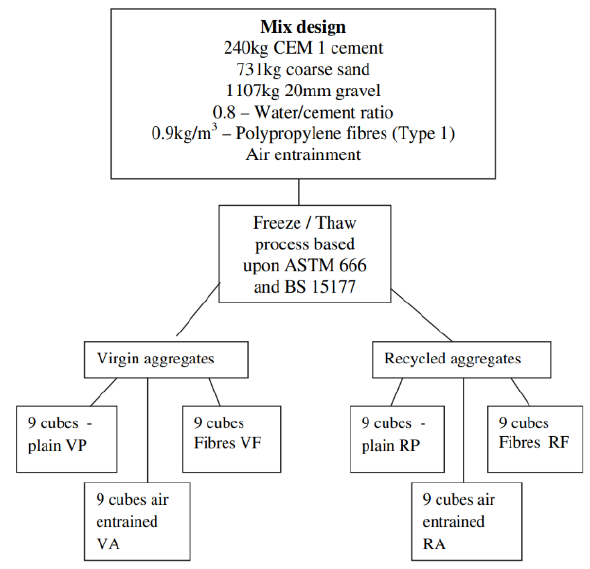
Figure 2. Schematic view of the fabrication process used in the recycled aggregate concrete and the concrete with virgin aggregates. Reprinted with permission from [22]. Copyright© 2011, Elsevier B.V.